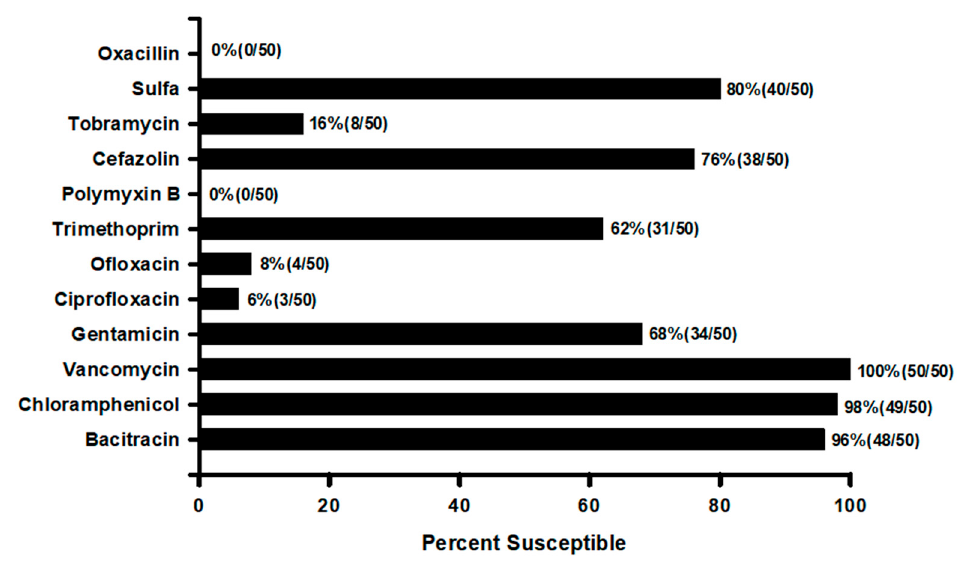
Figure 5. In vitro susceptibility of ocular MRSA to common topical